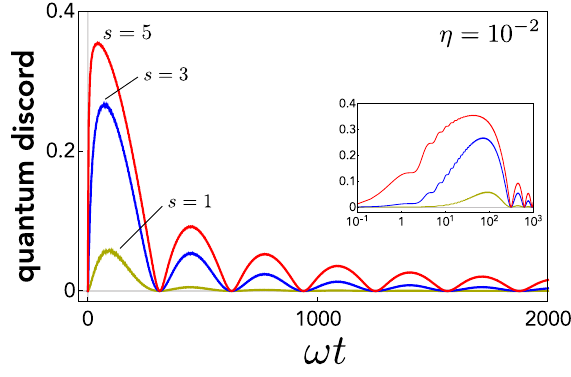
1 ) when each mass starts in a squeezed 2 10 . The inset contains the lin-log version − =